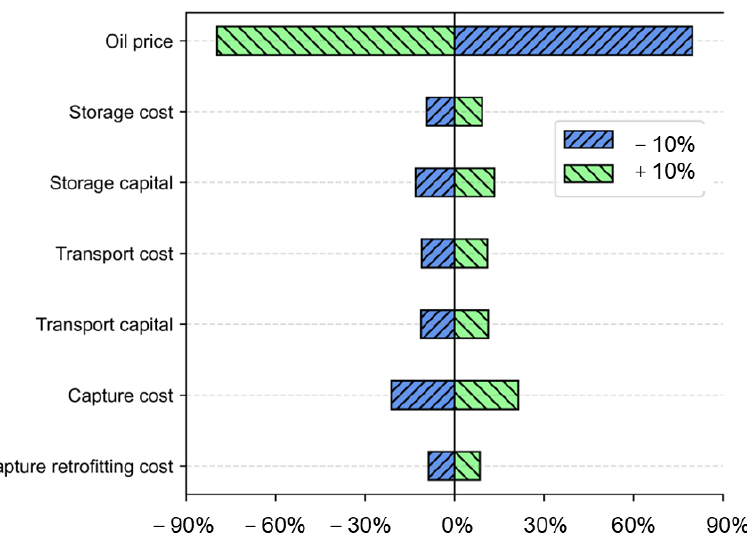
Figure 7. Sensitivity of key parameters to total abatement costs.